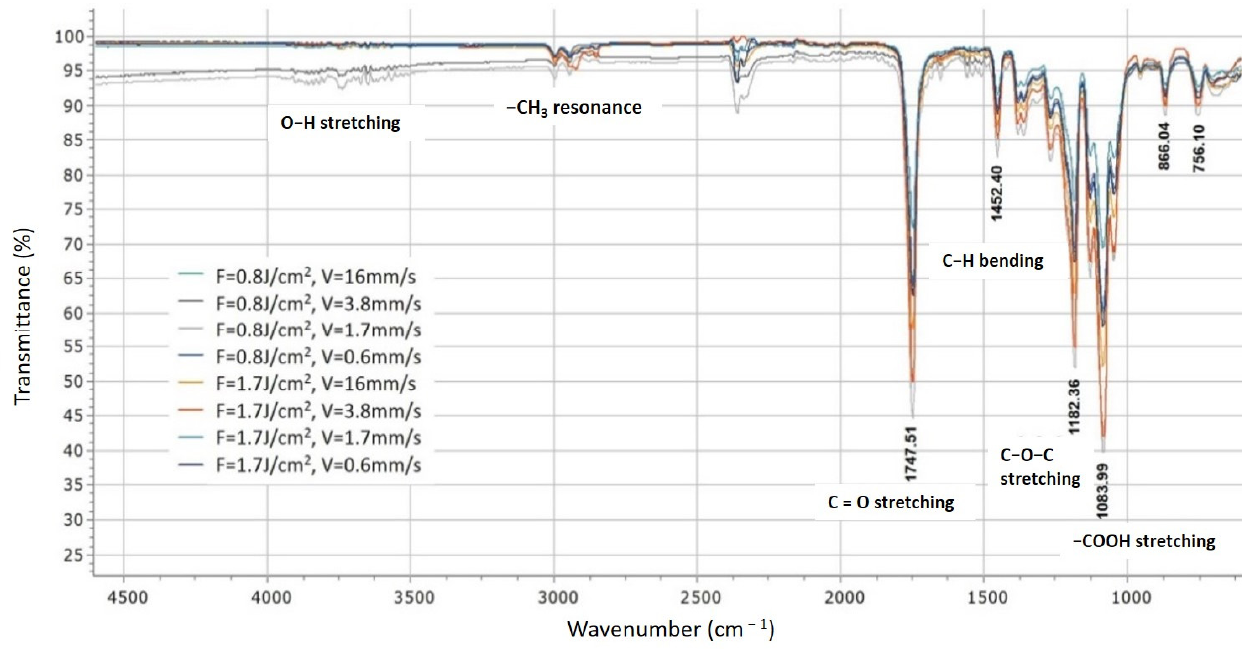
Figure 10. FTIR spectrum obtained for laser structured PLA surfaces treated by laser irradiation at F = 0.8 and 1.7 J/cm 2 , V = 16, 3.8, 1.7 and 0.6 mm/s.